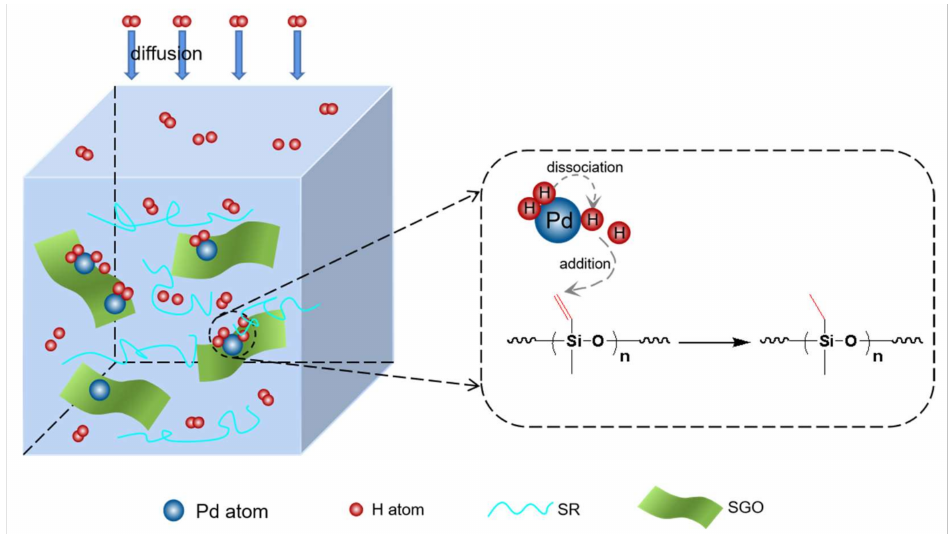
Figure 1. Hydrogen elimination mechanism of